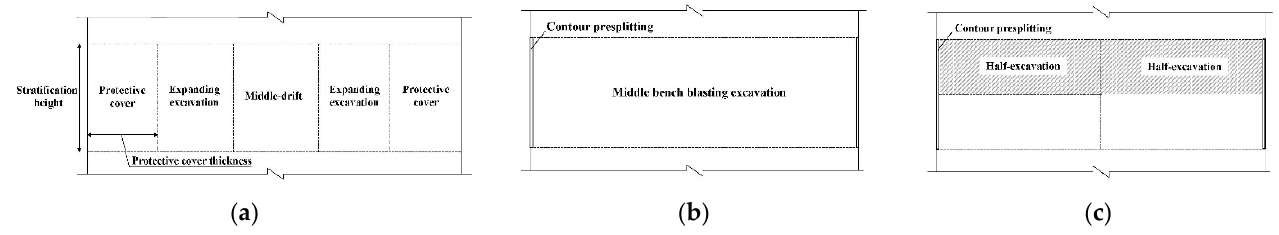
Figure 17. Excavation procedures of the high side wall zone. ( a ) MEP method; ( b ) CPMB method; ( c ) CPHB method.